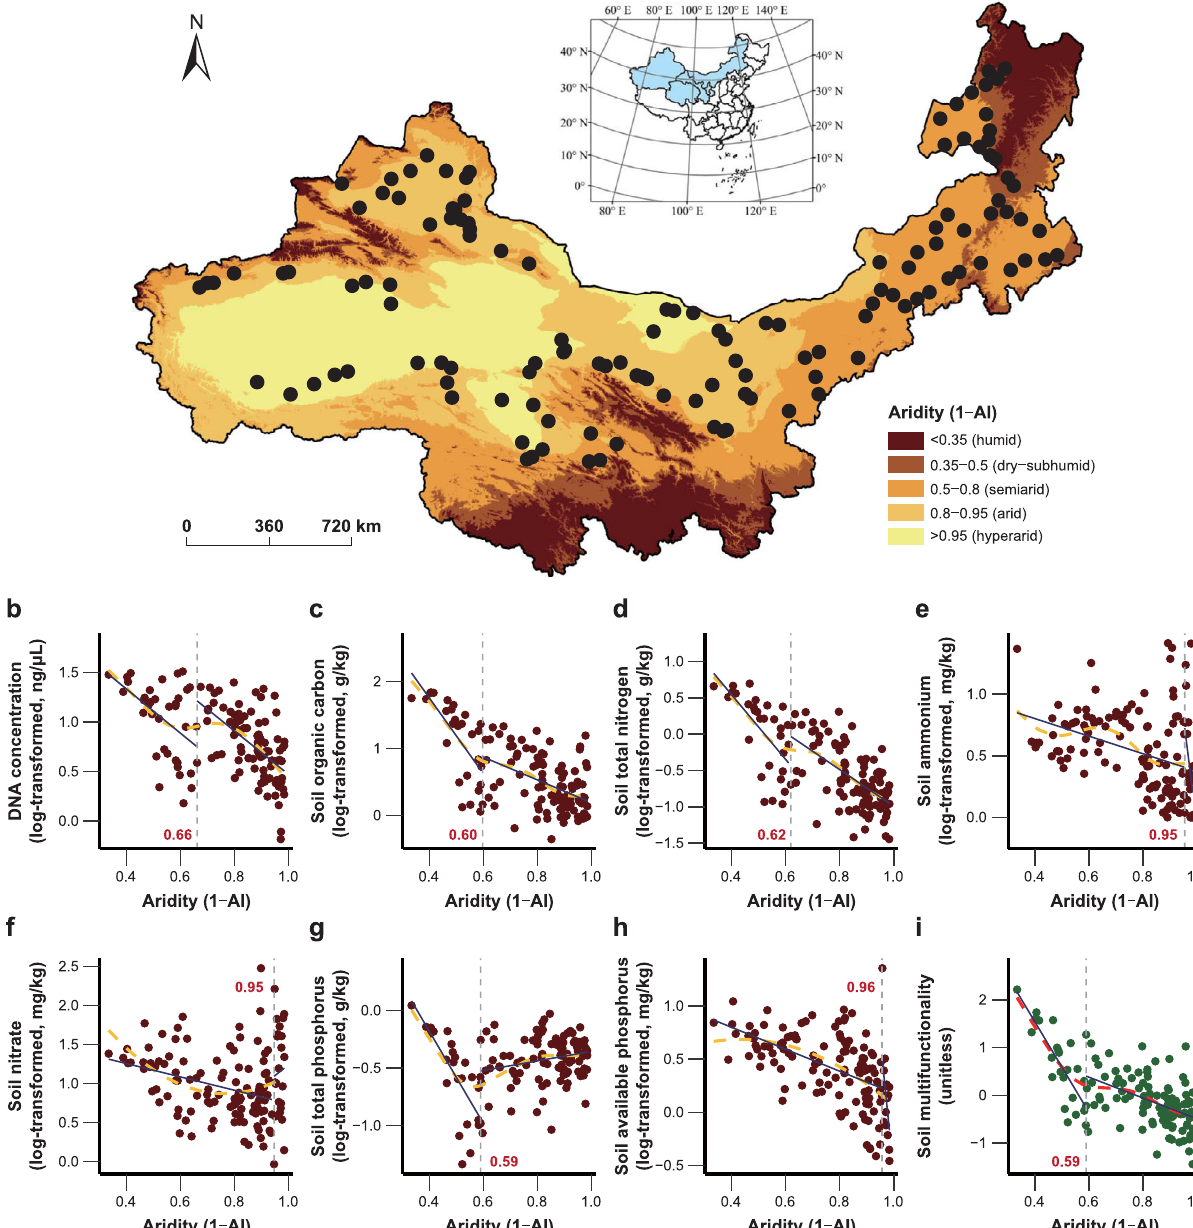
Fig. 2 Geographical distribution of fi eld sites and nonlinear responses of individual soil functions and multifunctionality to increasing aridity. a Map of the 130 fi eld sites in drylands across northern China. The sites represent the four different dryland subtypes (i.e., dry-subhumid, semiarid, arid, and hyperarid regions), which are de fi ned with different aridity levels, as demonstrated in the legend. Inset map shows China with the study area colored in light blue. b – i Nonlinear responses of DNA concentration ( b ), soil organic carbon ( c ), total nitrogen ( d ), ammonium ( e ), nitrate ( f ), total phosphorus ( g ), available phosphorus ( h ), and soil multifunctionality ( i ) to aridity, and their respective aridity thresholds. The orange and red dashed lines indicate the nonlinear trends fi tted by quadratic or generalized additive models (GAMs). The gray dashed lines and inset numbers in red represent the aridity thresholds identi fi ed. The blue solid lines denote the linear fi ts at both sides of each aridity